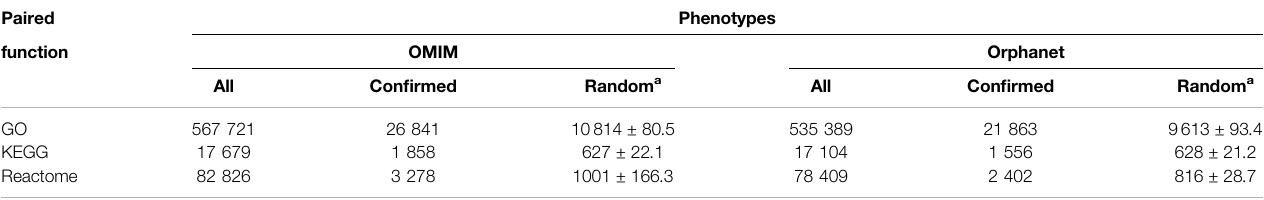
TABLE5| Co-mentionvalidationofphenotype-functionpairs. “ All ” correspondstoallpairsincludingafunctionfrom Table4 . “ Con fi rmed ” referstothenumberofthesepairs that were signi fi cantly co-mentioned in PubMed. “ Random ” refers to the number ofpairs in a randomised list based on “ All ” pairs that were signi fi cantly co-mentioned in PubMed; average of 100 random datasets ± SD is shown in this